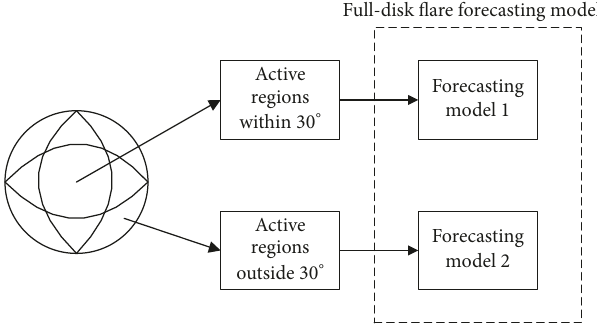
Figure 1: Full-disk solar flare forecasting